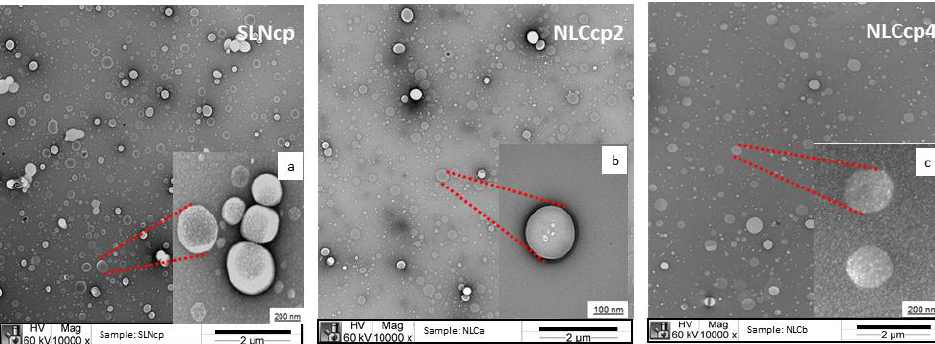
Figure 3. Transmission electron microscopy of SLNcp ( a ), NLCcp2 ( b ), and NLCcp4 ( c ) display the morphology and size of the lipid-based nanoparticles. Images with 10,000× and 60,000× (red highlight) of magnification give polydispersity and details of some nanoparticles, respectively.